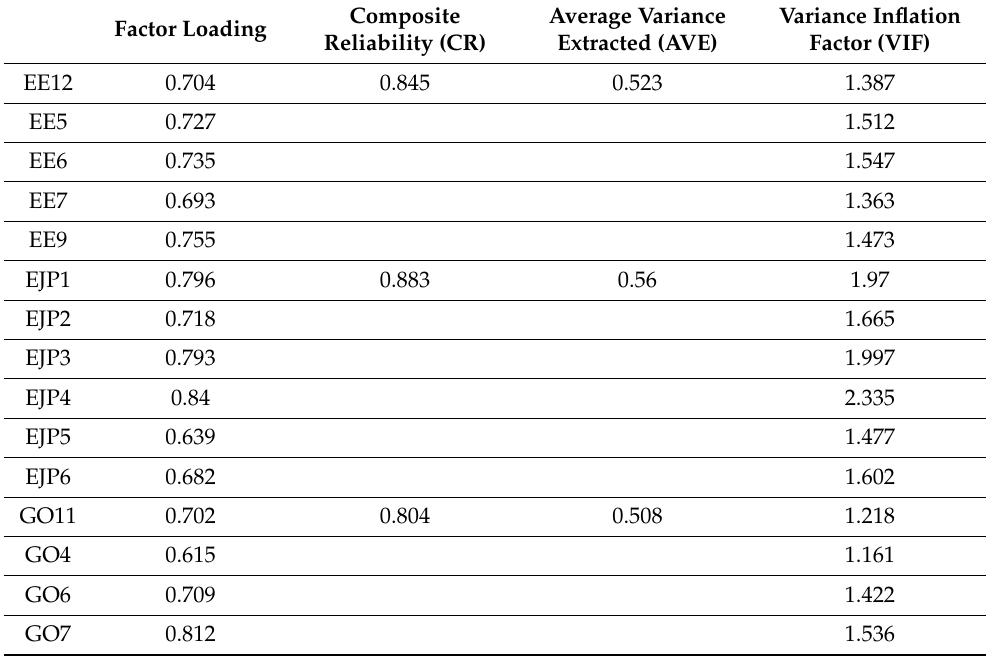
Table 3. Validity and Reliability of Questionnaire.